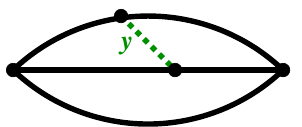
Figure 16 . If colors (red vs. blue) are not shown, and if the momentum fractions associated with the underlying g → gg process (black lines above) are not shown, then all of the ABC diagrams can be drawn in the same form, shown